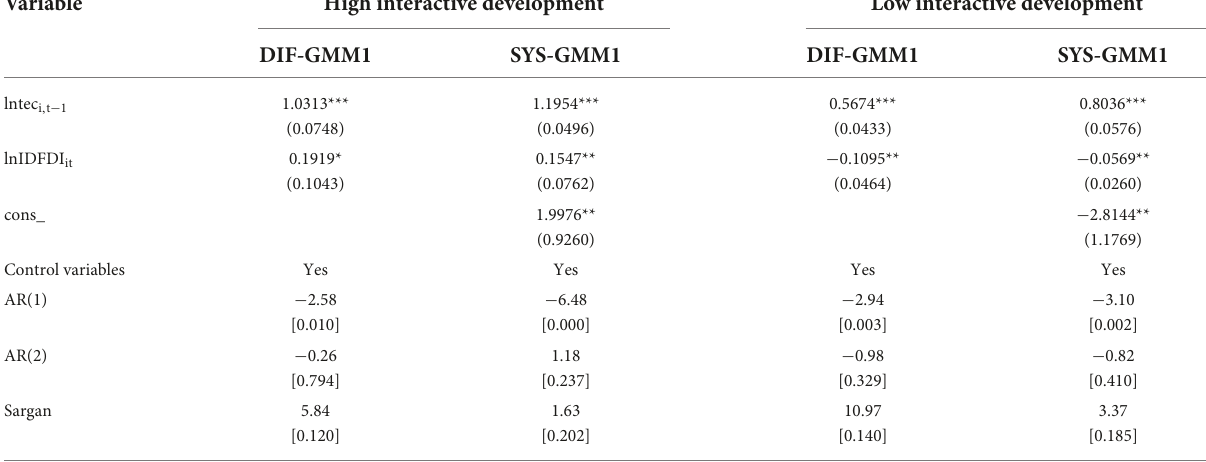
TABLE 8 Heterogeneity analysis of the development degree of two-way foreign direct investment (FDI) interaction.